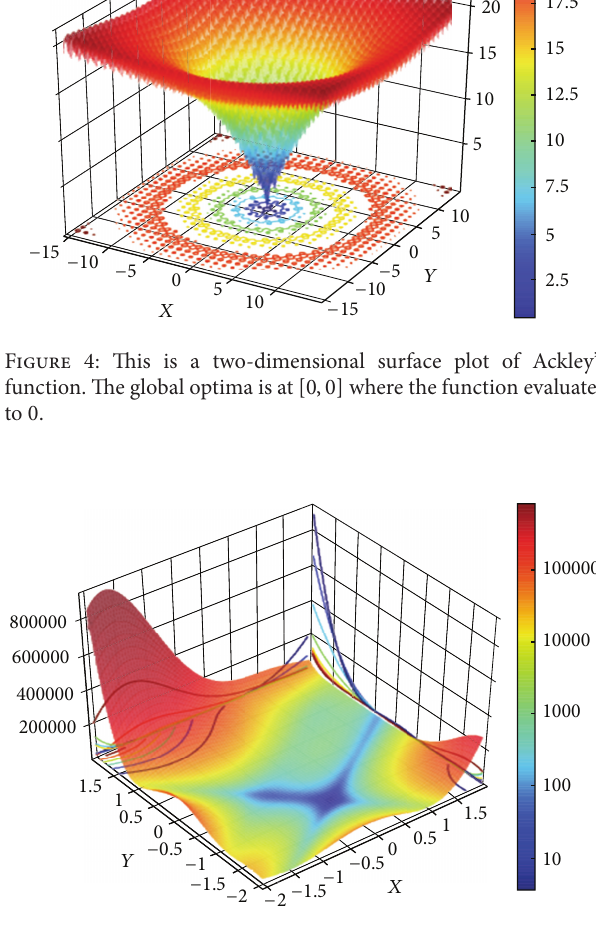
Figure 5: The Goldstein-Price polynomial is only defined in two variables and is shown here evaluated in the −2 ≤ 𝑥 1 , 𝑥 2 ≤ 2